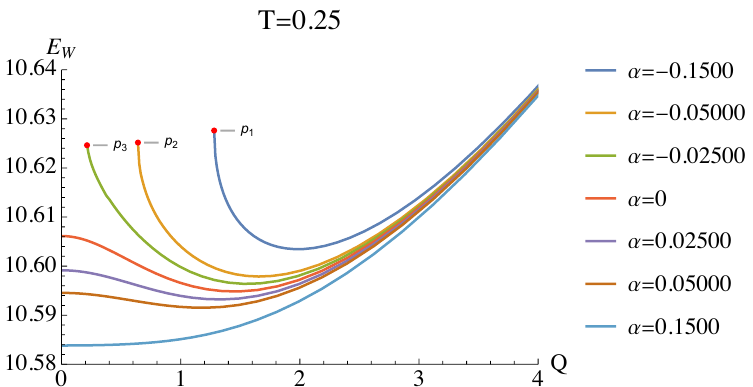
Figure 11 . The EWCS vs Q in different value of α and the configuration ( a, b, c ) is (0 . 6 , 0 . 1 , 0 . 3) . The EWCS behave non-monotonicity with the increase of charge Q , which also will vanish if α takes a rather larger value. Three red points represent the critical charge Q .